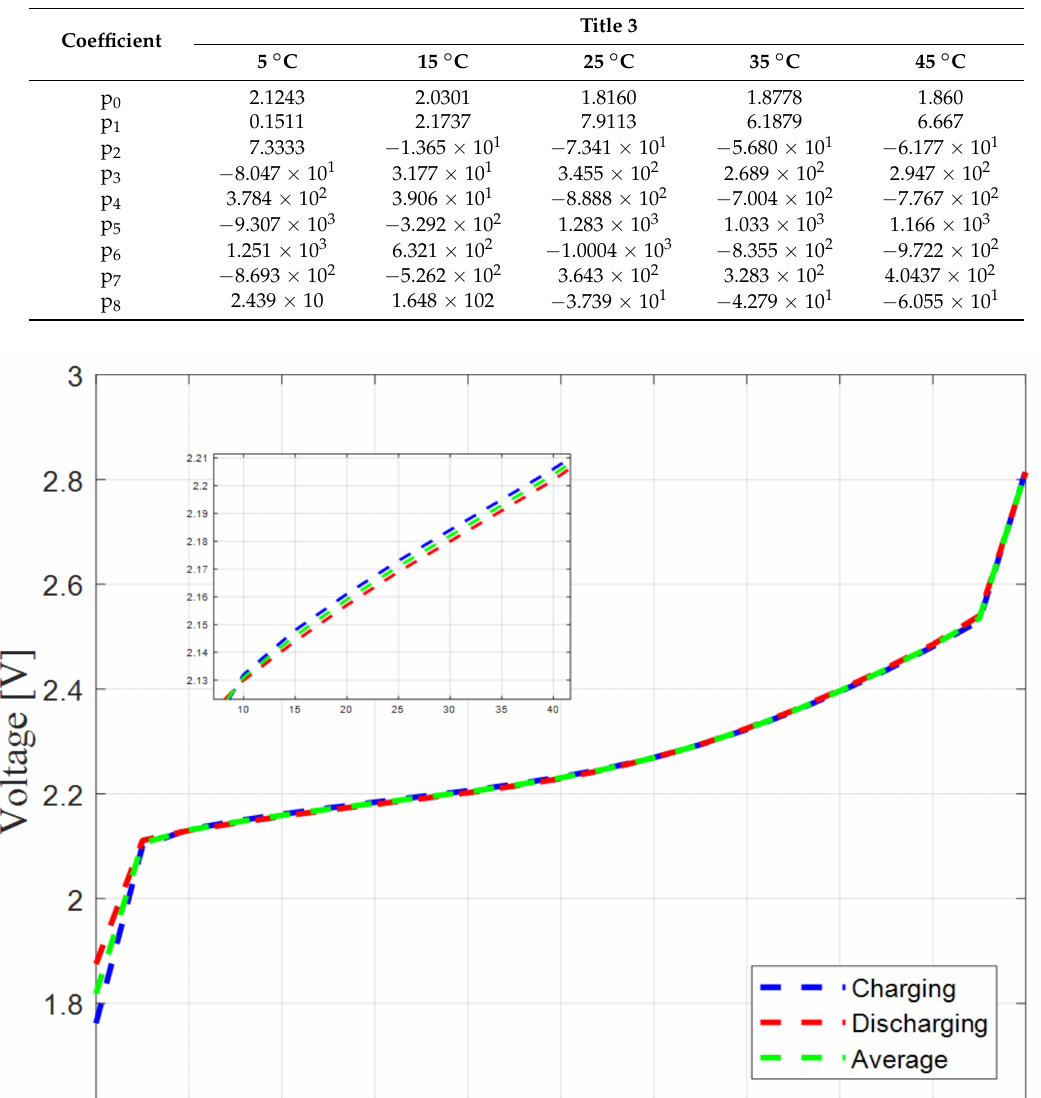
Table 2. Polynomial approximation of the OCV-SOC characteristic.